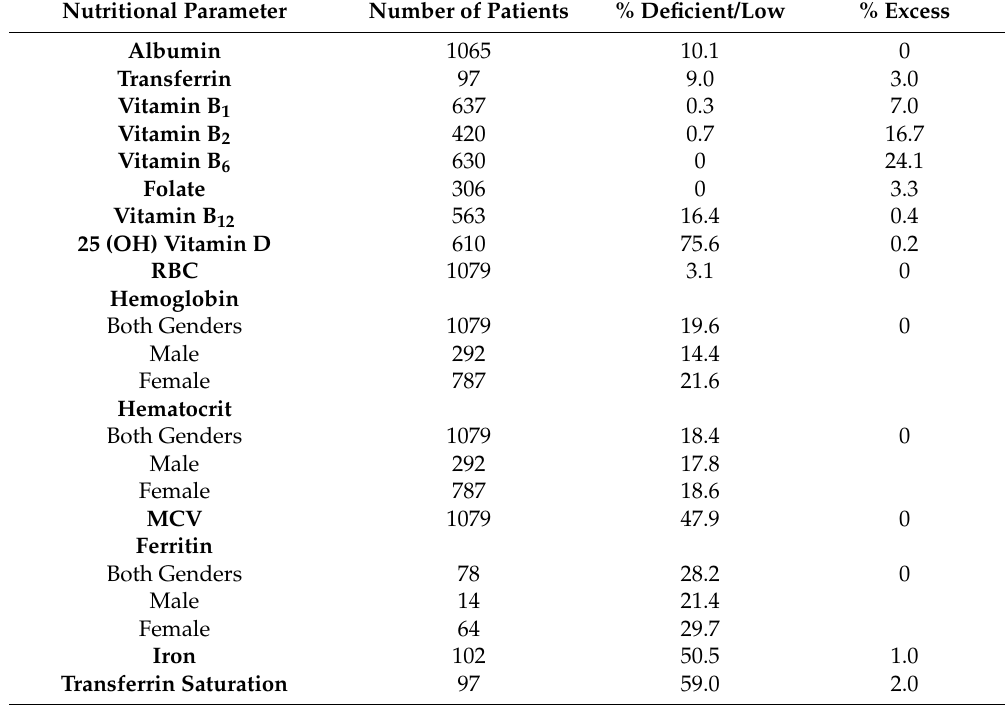
Table 3. Prevalence of deficient and excess nutrient levels pre bariatric